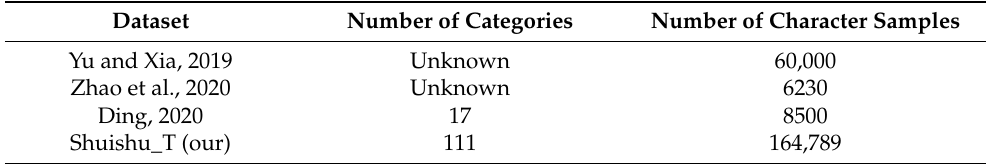
Table 2. Comparison of other datasets of same class.